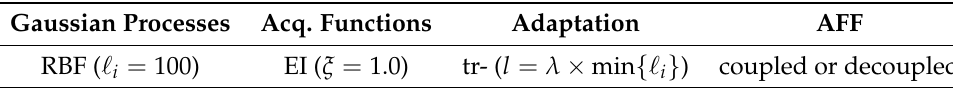
Table 3. Definition of MEBO proposed model. Note that two hyperparameters, λ and AFF, are defined as